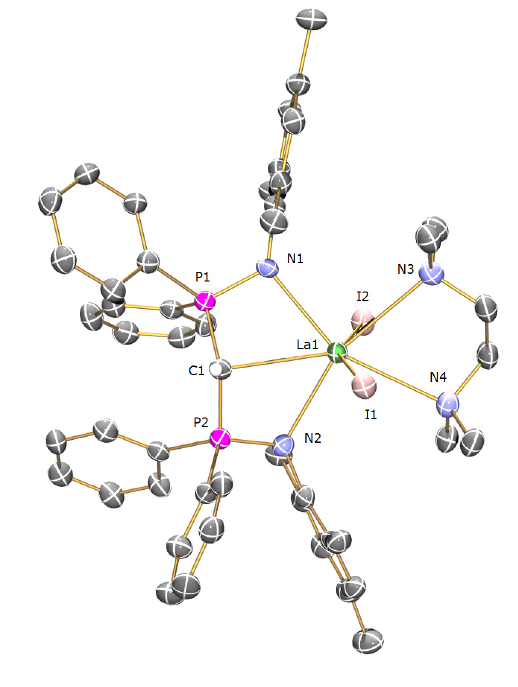
H with selected atom labelling. Displacement 7 8 H is very 7 8